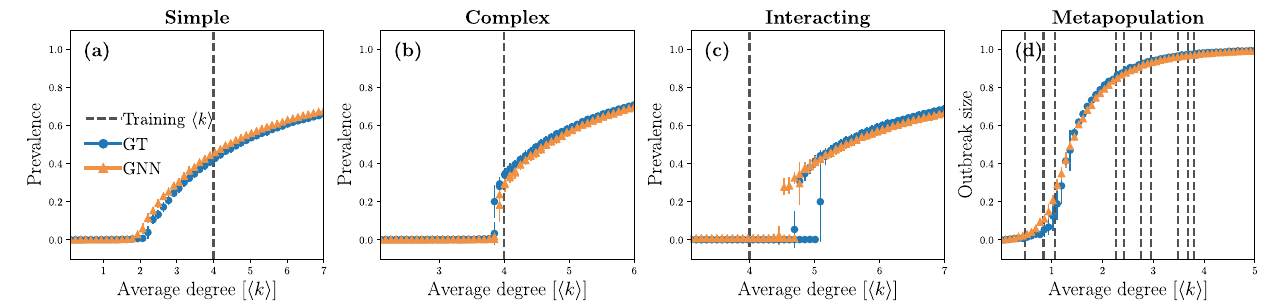
Fig. 3 Bifurcation diagrams of the trained GNN. a Simple contagion dynamics. b Complex contagion dynamics. c Interacting contagion dynamics. d Metapopulation dynamics. In these experiments, we used Poisson networks composed of j V j ¼ 2000 nodes with different average degrees h k i . The prevalence is de fi ned as the average fraction of nodes that are asymptotically infected by at least one disease and the outbreak size corresponds to the average fraction of nodes that have recovered. These quantities are obtained from numerical simulations using the "ground truth" (GT) dynamics (blue circles) and the GNN trained on Barabási-Albert networks (orange triangles). The error bars correspond to the standard deviations of these numerical simulations. The trained GNN used are the same ones as those used for Fig. 2. As a reference, we also indicate with dashed lines the value(s) of average degree 〈 k 〉 corresponding to the network(s) on which the GNN were trained. On d , more than one value of 〈 k 〉 appear as multiple networks with different average degrees were used to train the GNN (see Sec. "Graph neural networks and training details").